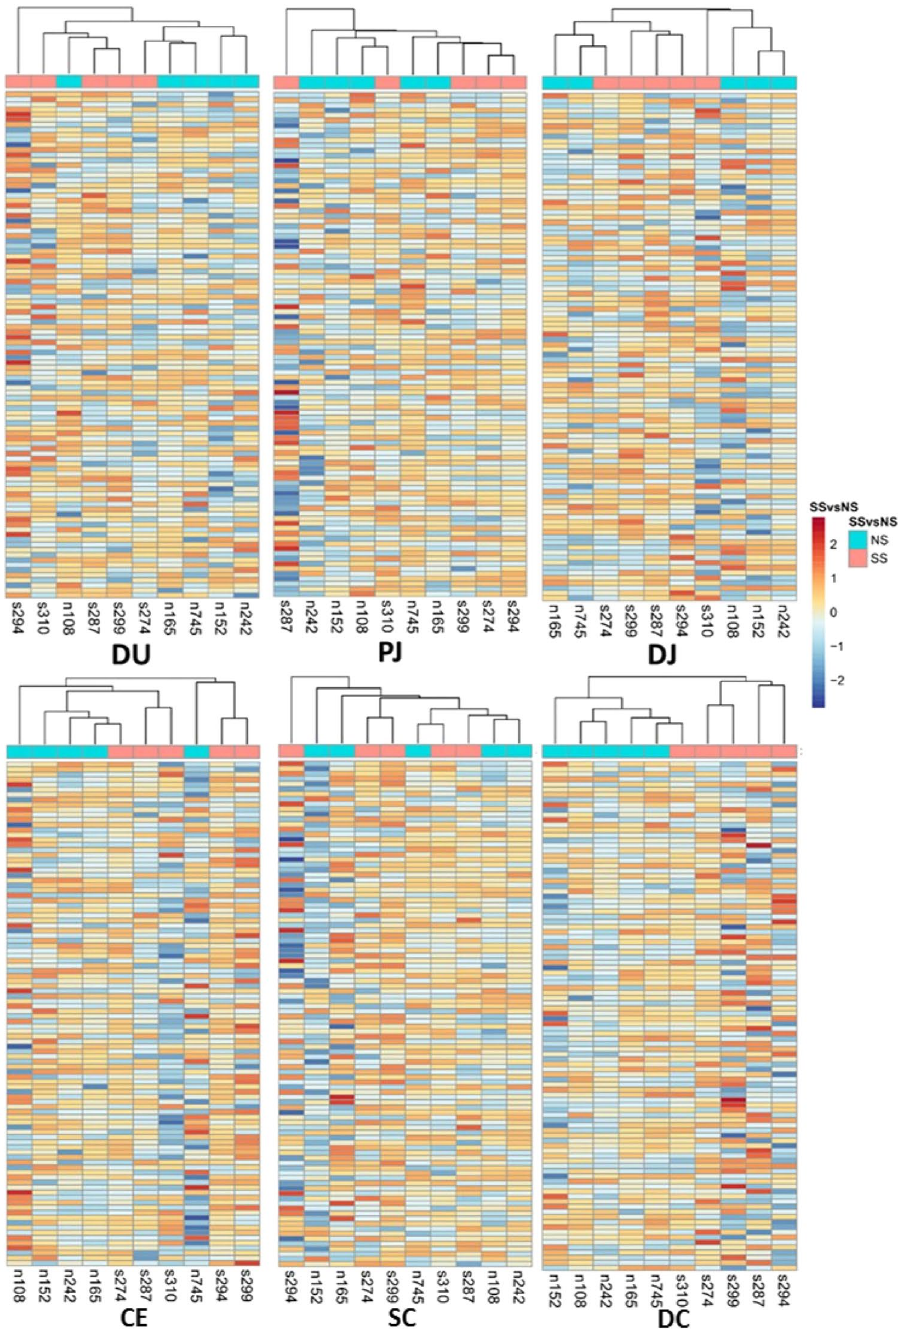
Figure 1. Heatmaps for core transcriptome of all tissues. The genes in core transcriptomes were first aggregated into 100 clusters using k-means clustering. DU, duodenum; PJ, proximal jejunum; DJ, distal jejunum; CE, cecum; SC, spiral colon; DC, descending